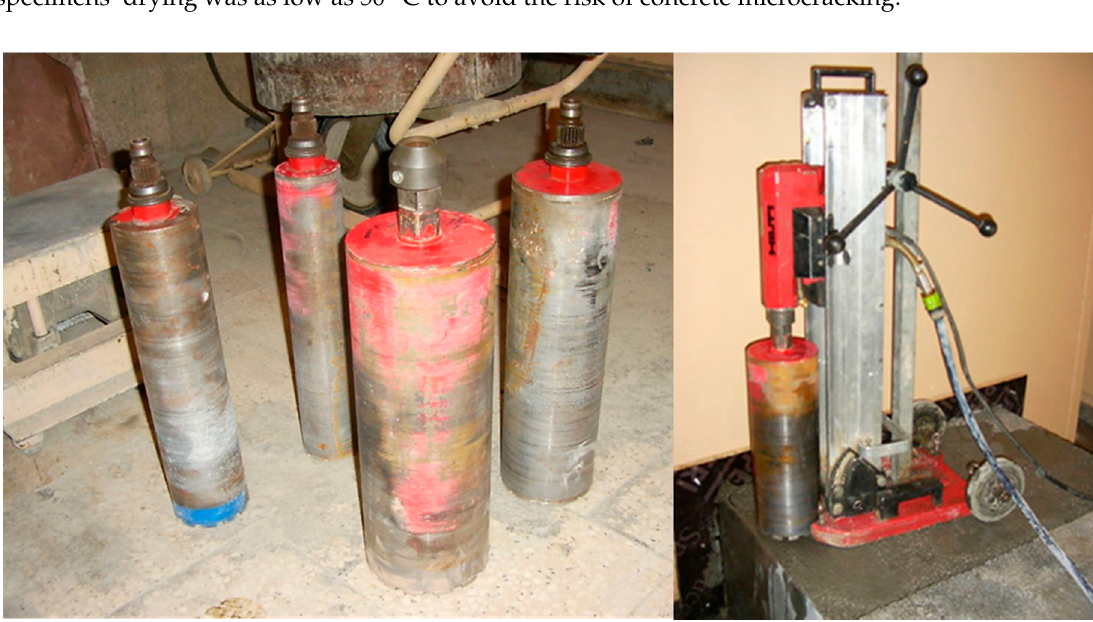
Figure 3. Types of drilling rigs used (d = 80, 100, 125, 150 mm) and cutting out cores from a concrete block.